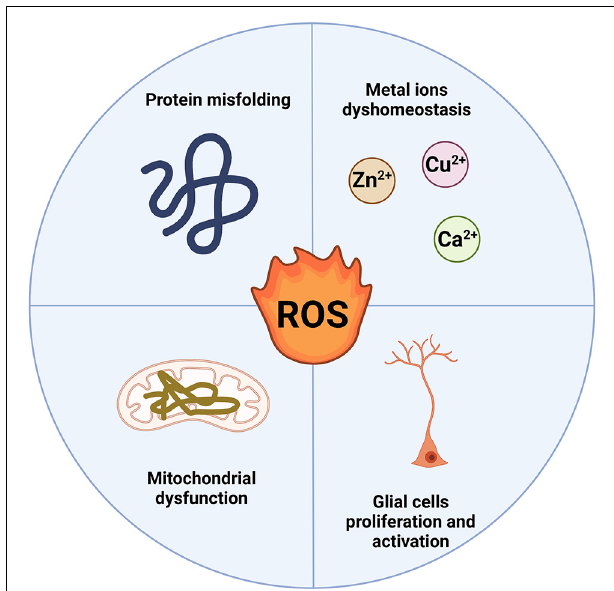
FIGURE 1 | ROS production in neurodegenerative diseases. Protein misfolding, metal ions dyshomeostasis, mitochondrial dysfunction, and glial cell proliferation and activation mainly induce the ROS production in NDs. At the same time, the overproduction of ROS can also affect the four pathological processes (Created with BioRender.com). ROS, reactive oxygen species; NDs, neurodegenerative